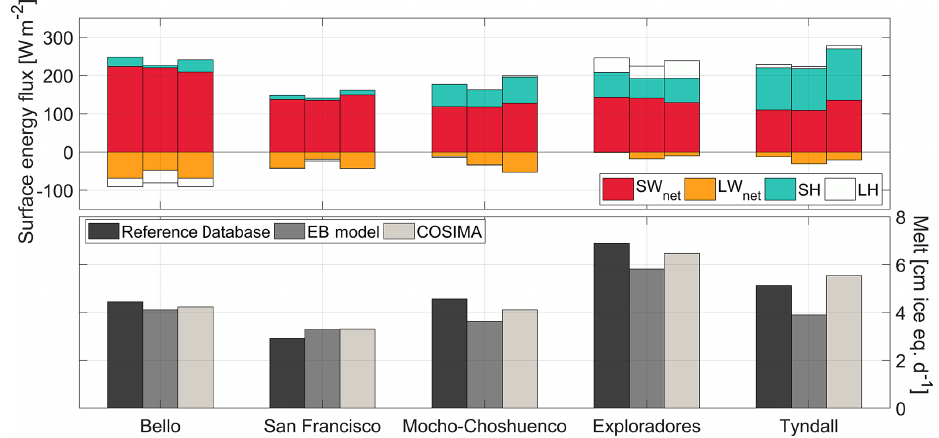
Figure 5. Mean modeled and measured energy fluxes and melt during summer for five glaciers: left bar, Reference Database; middle bar, EB model; right bar, COSIMA. Table 5. Mean values of the computed surface energy fluxes and melt rates during the study periods on the five studied glaciers using the three different methods. For the Reference Database, turbulent fluxes and melt rates calculated without using stability corrections are indicated in